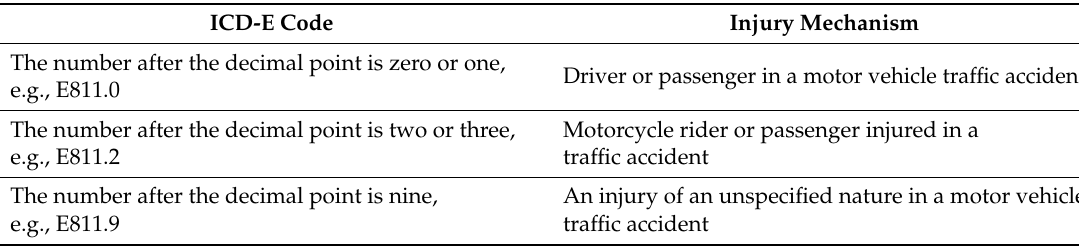
Table 2. ICD-E codes and injury